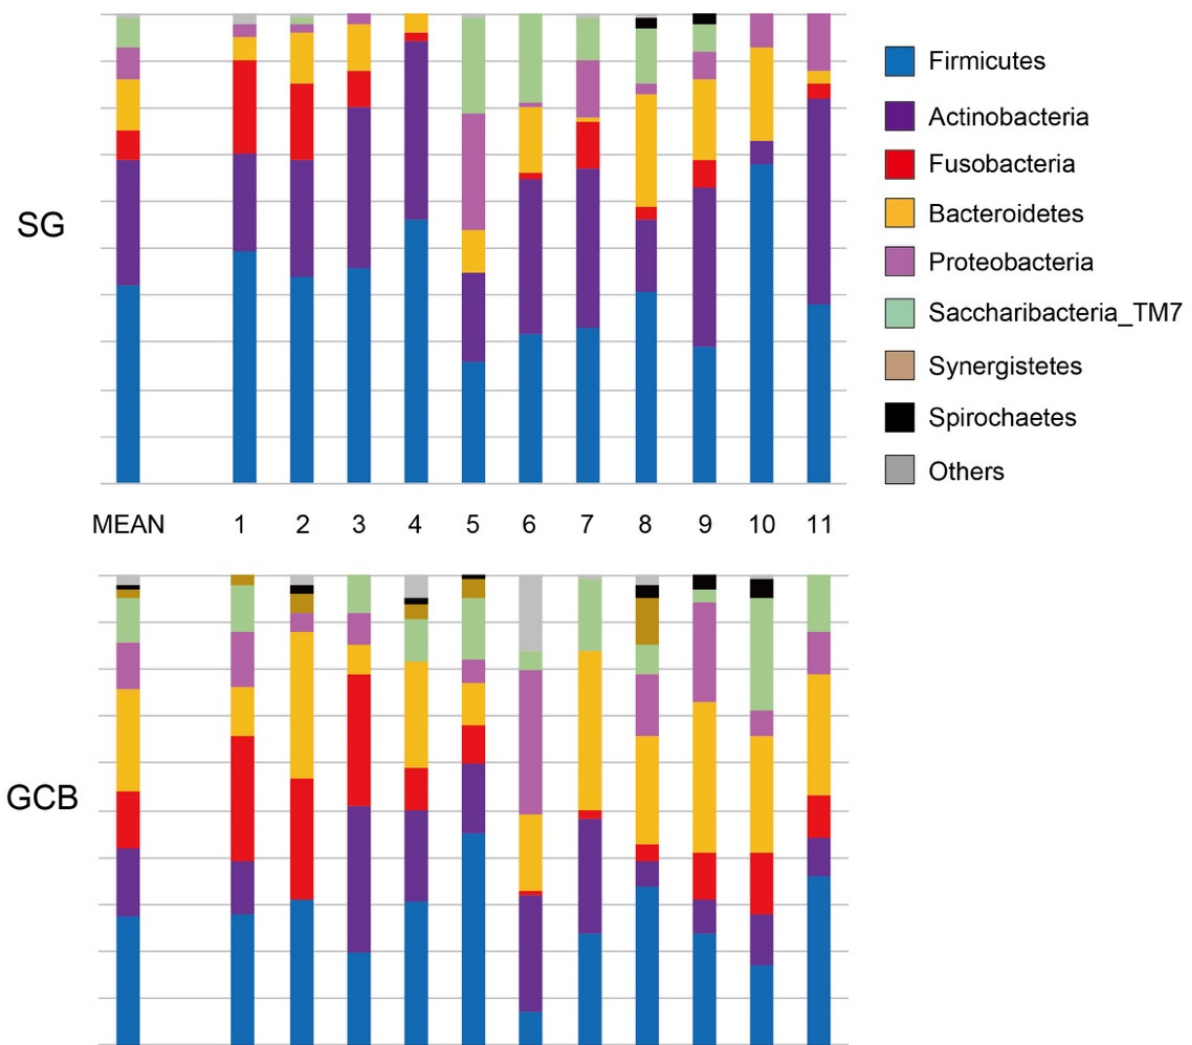
Figure 3. Distribution pattern of 8 phyla in root caries lesions. SG: root caries that existed independently above the gingival margin, GCB: root caries that progressed below the gingival margin.